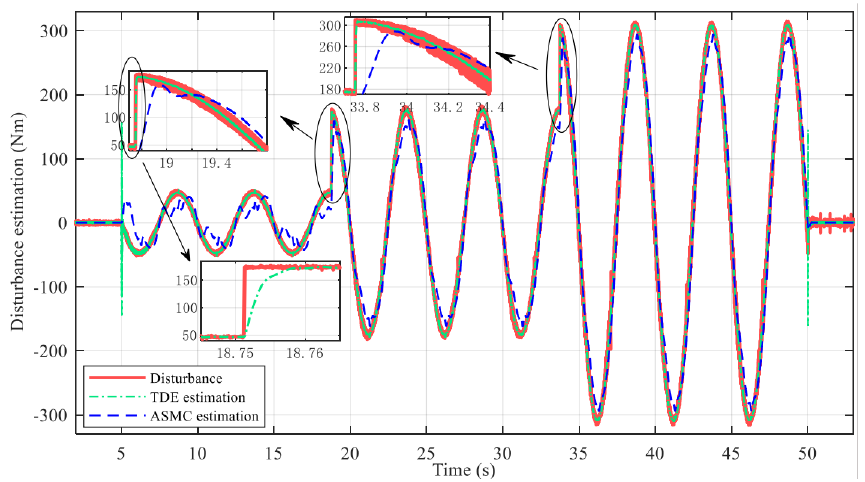
Figure 5. Estimation of disturbance torque in slalom path following.